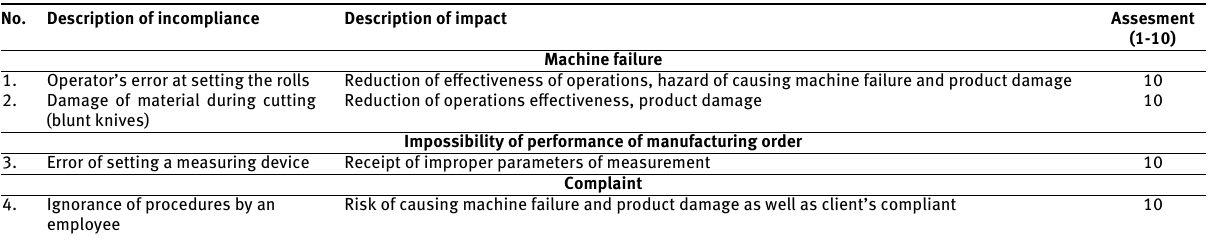
Table 5: Impact of incompliance on effective implementation of a cutting